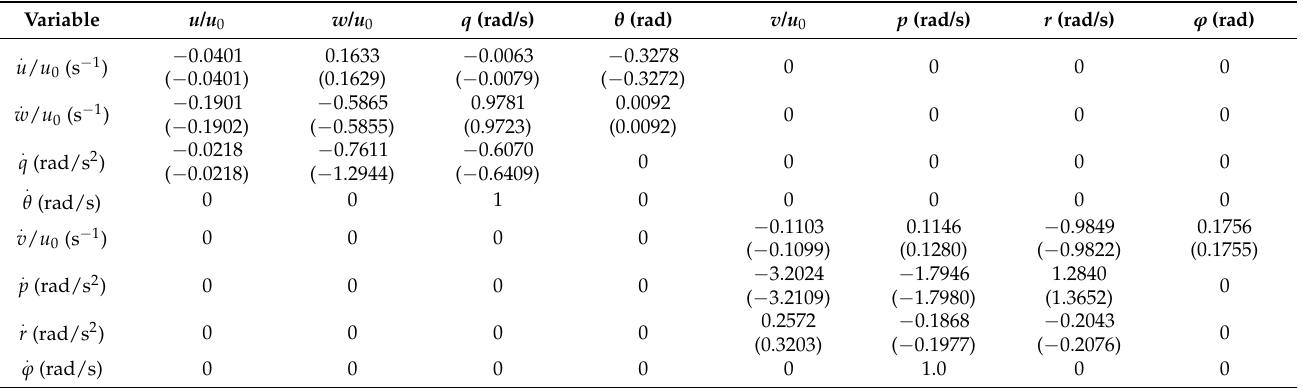
Table 9. CFD–RANS (extrapolated) 8 × 8 stability matrix for flight condition 2 in Tables 4 and 5 (reference landing case).